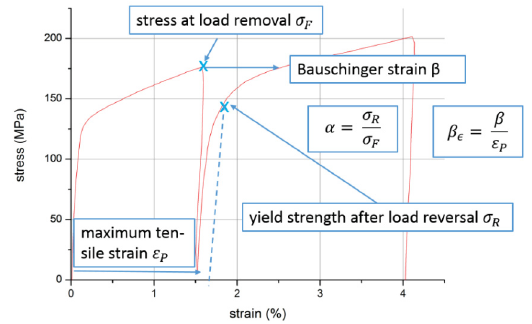
Figure 10. Stress-strain curve of compressive stress [26]